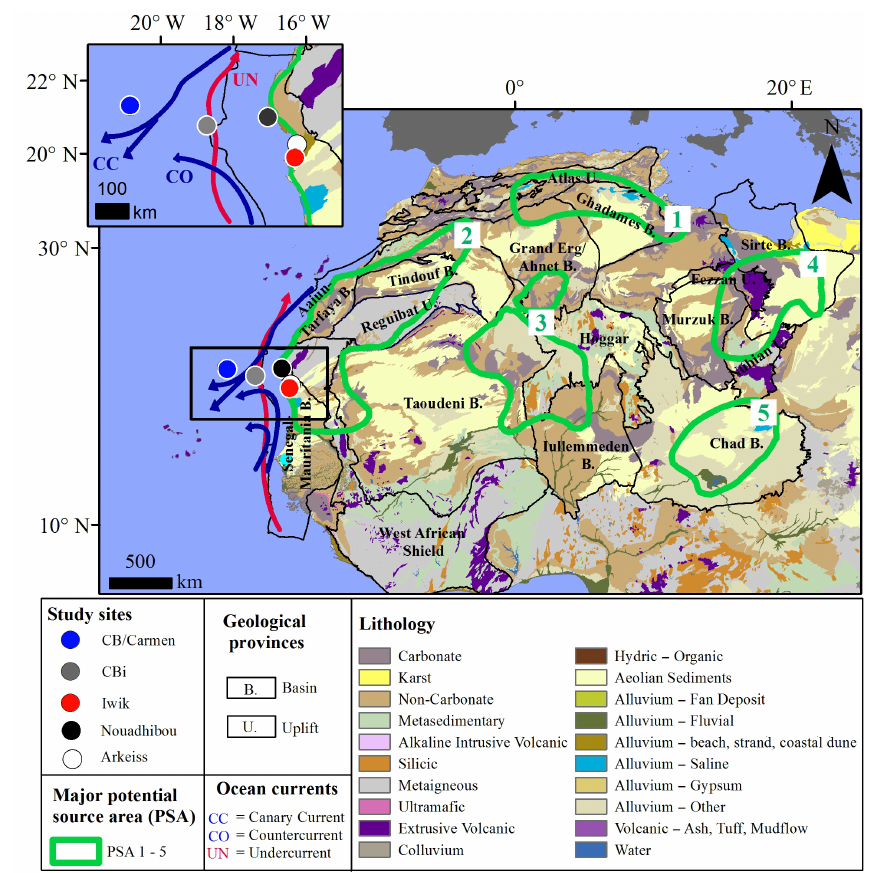
Figure 1. Map of the study sites under investigation: the scientific buoy Carmen as well as the sediment trap moorings CB and CBi off Cap Blanc, the MWAC (modified Wilson and Cooke) dust collector onshore near Iwik, and the surface station near Nouâdhibou and Arkeiss (shapefile of the surface lithology and the geological provinces: downloaded from the USGS website https://rmgsc.cr.usgs.gov/outgoing/ ecosystems/AfricaData/ and http://certmapper.cr.usgs.gov/geoportal/catalog/main/home.page; major potential dust source areas: redrawn from Scheuvens et al. (2013); ocean currents: redrawn from Mittelstaedt,